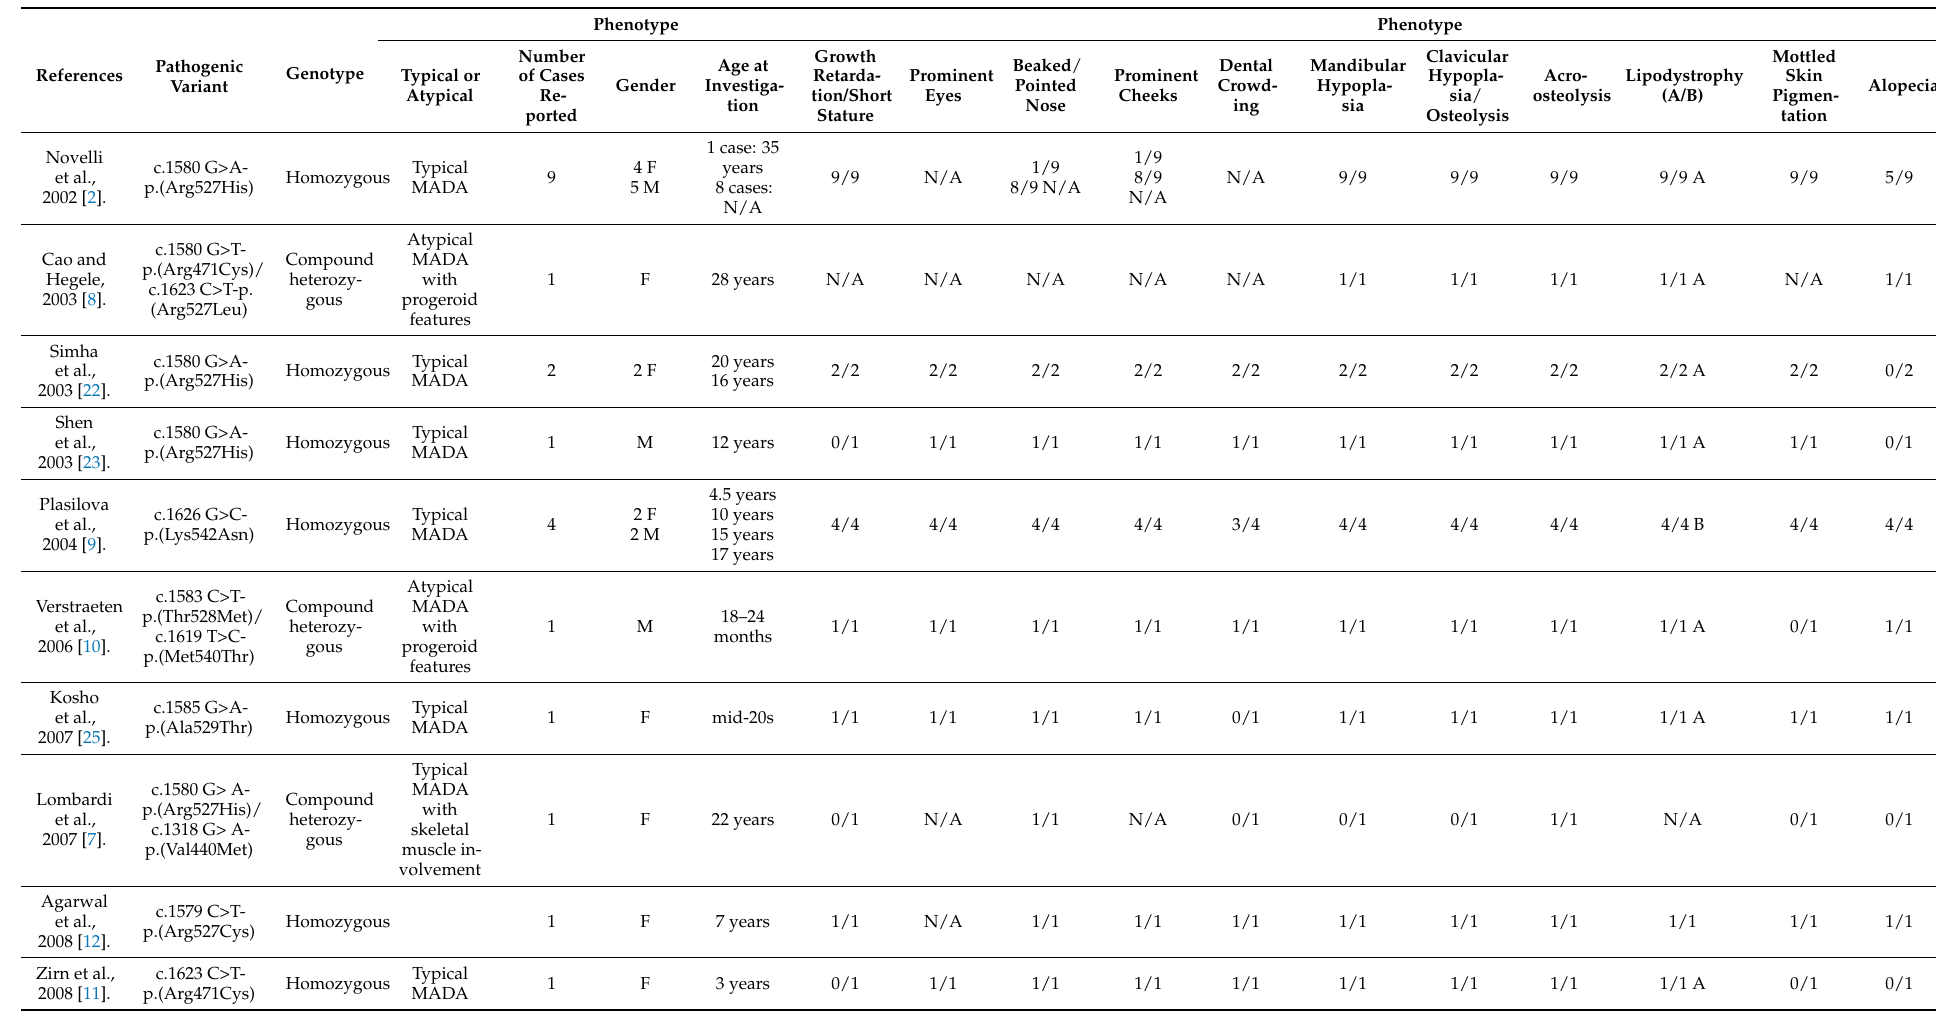
Table 2. Full list of published cases of MADA with biallelic LMNA pathogenic variants (in chronological order) and their corresponding phenotypes. For each gene mutation, the nucleotide mutation (c.) and corresponding amino acid change (p.) are indicated. N/A: not